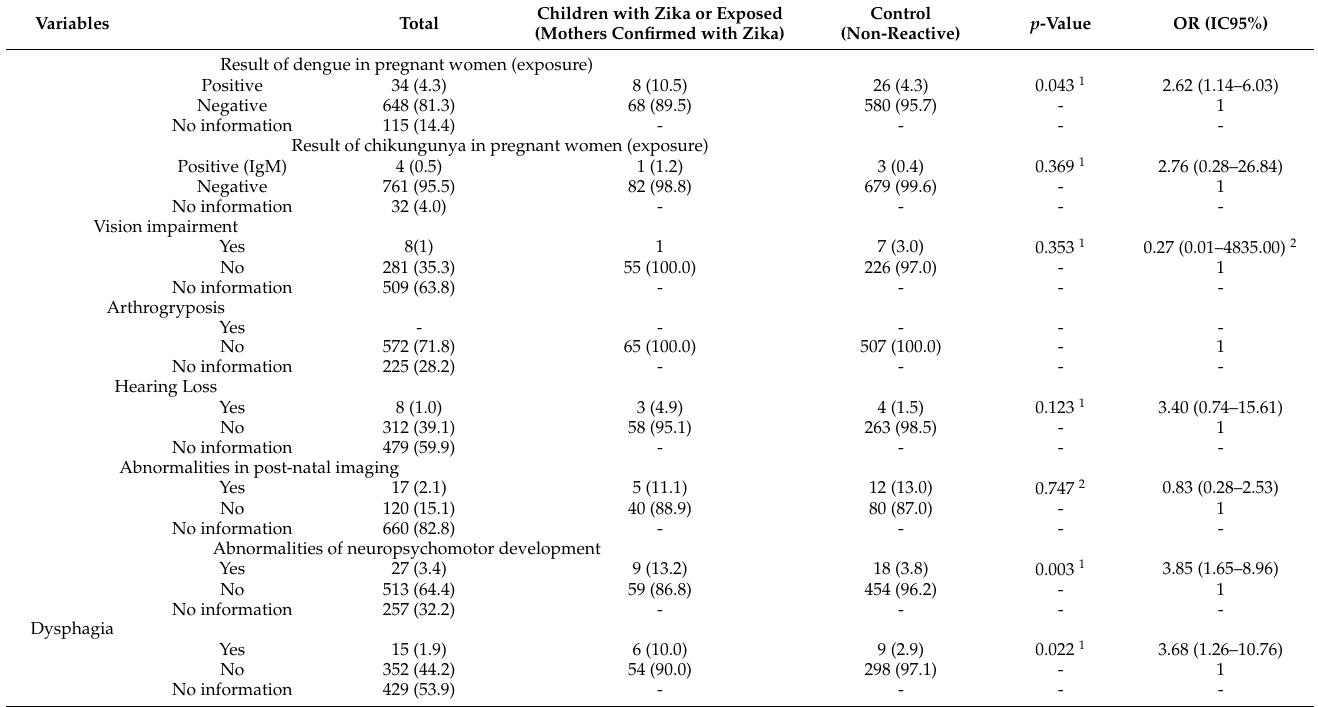
Table 5. Clinical and laboratory findings of the ZIKV-exposed children, Jundia í Medical School, 2016–2019. Variables Total Children with Zika or Exposed (Mothers Confirmed with Zika) Control (Non-Reactive) p -Value OR (IC95%) Result of dengue in pregnant women (exposure) Positive 34 (4.3)